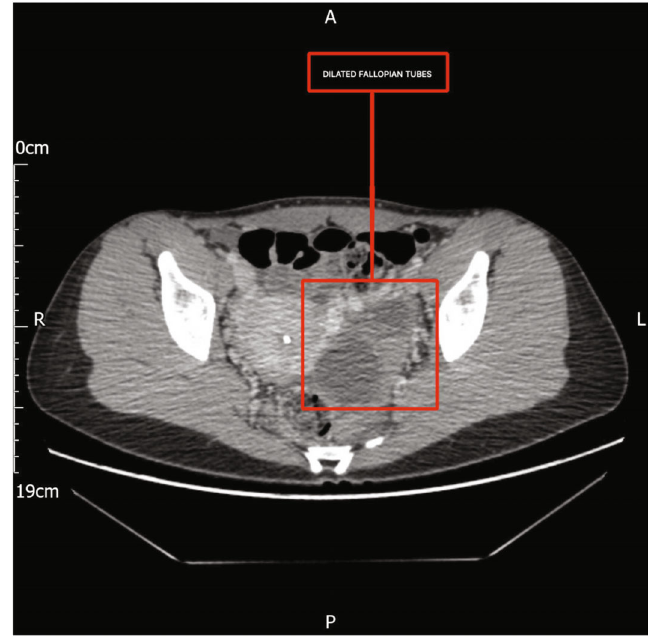
Figure 2: CT scan images. CT scan impression: − 7 × 8 cm cystic structure noted in the left adnexa — tubo-ovarian abscess